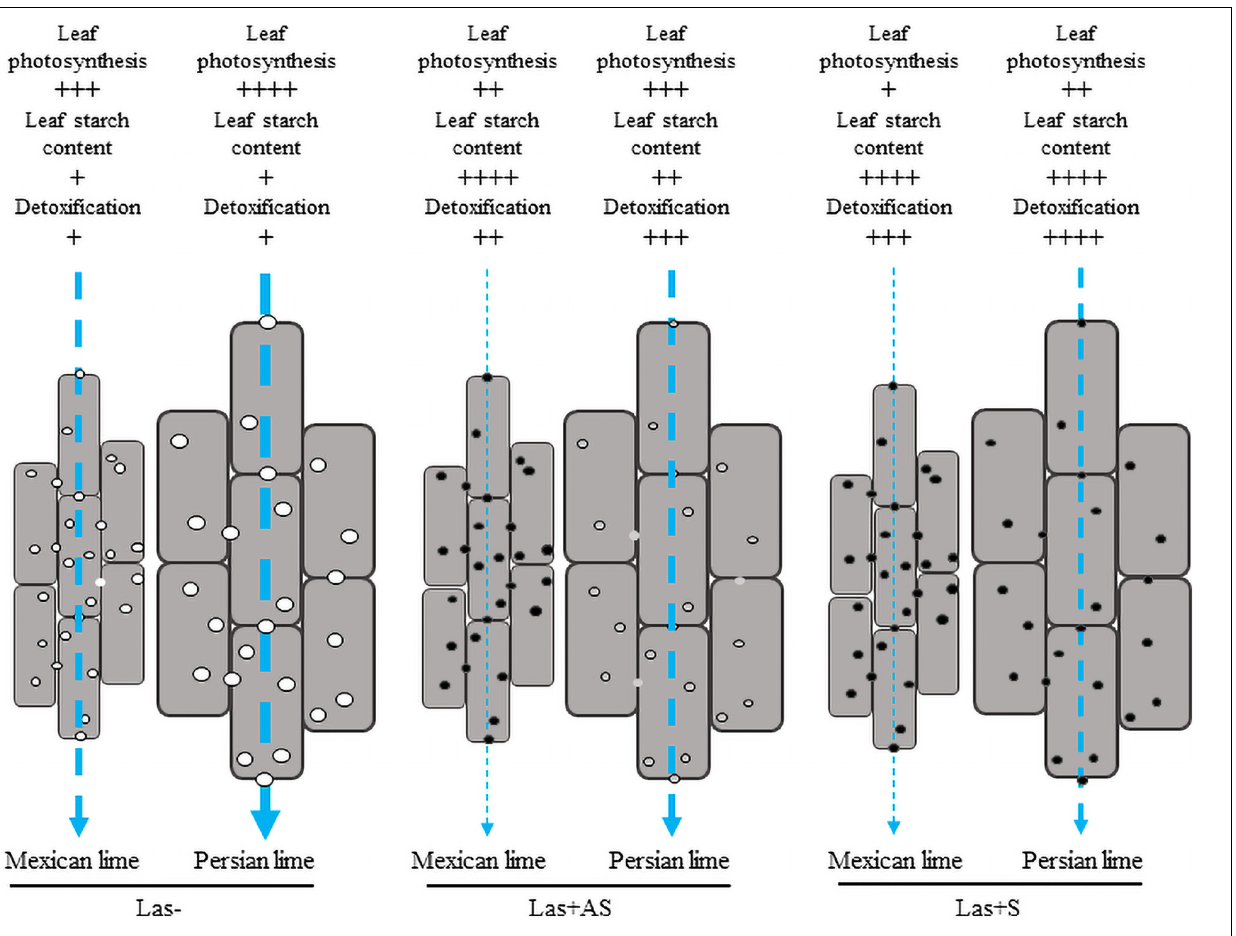
FIGURE 4 | Cellular model reflecting the impact of HLB at the leaf level with regard to phloemic sap flow in the petioles of the control (Las − ) as well as infected leaves that were asymptomatic (Las + AS) and symptomatic (Las + S) from Mexican and Persian limes, respectively. Vertical arrows indicate the expected strength of the phloemic sap flow. In the control petiole, the pores and the cells are bigger, and the photosynthetic rate in the Persian lime is higher compared with the Mexican lime. Thus, the phloemic sap flux is expected to be higher in Persian lime than in the Mexican lime, which may favor the growth rate of the Persian lime. In Las + AS leaves, the photosynthetic rate and the detoxification are higher in the Persian lime than in the Mexican lime. The pores in the Mexican lime are clogged, which favors the accumulation of starch in leaf; however, pores are still open in the Persian lime, which helps with maintaining the flow of phloemic sap in that genotype. In Las + S leaves, the photosynthetic rate and the detoxification are still higher in the Persian lime than in the Mexican lime even though all pores are clogged. In both genotypes, a strong increase in the starch content is observed. One may expect, however, that for a given petiole length to cross, the larger size of the cells in the Persian lime corresponds to a more limited number of cell walls of the phloem to cross than in the Mexican lime. Associated with a greater photosynthetic rate, this will help in maintaining a higher phloemic sap flow in Persian lime Las + S than in Mexican lime Las + S. content was consistent with a better HLB tolerance